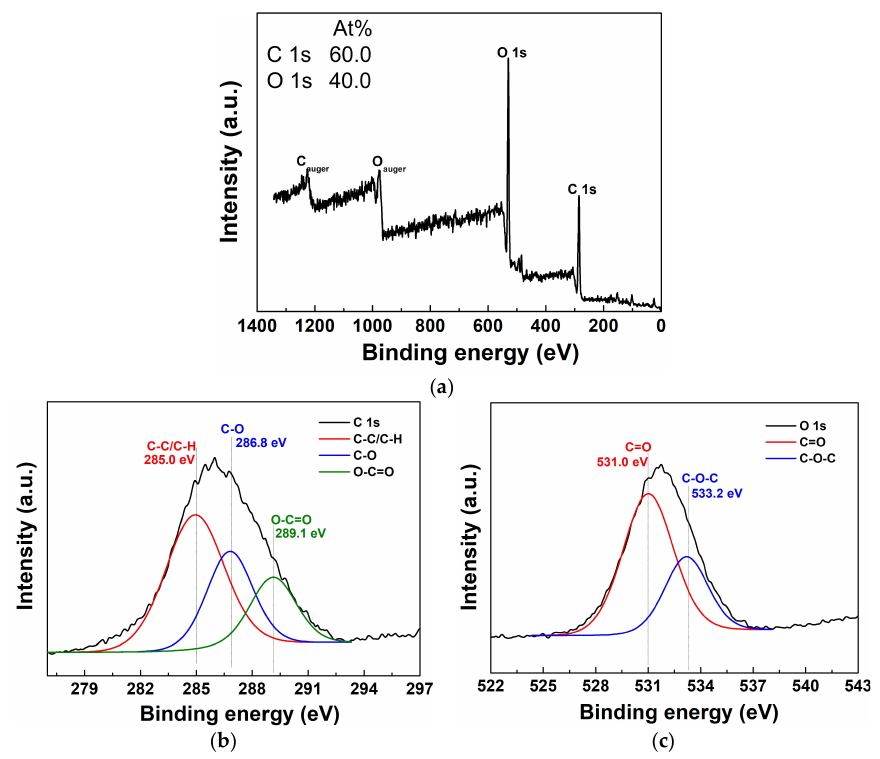
Figure 2. ( a ) X-ray photoelectron spectroscopy (XPS) survey spectra, detailed high-resolution with deconvolutions of ( b ) C 1s, and ( c ) O 1s spectra of pPMMA thin films grown on a glass substrate when using the proposed APP polymerization technique after 90 min deposition. Insets in (a) represent the atom percent in the pPMMA